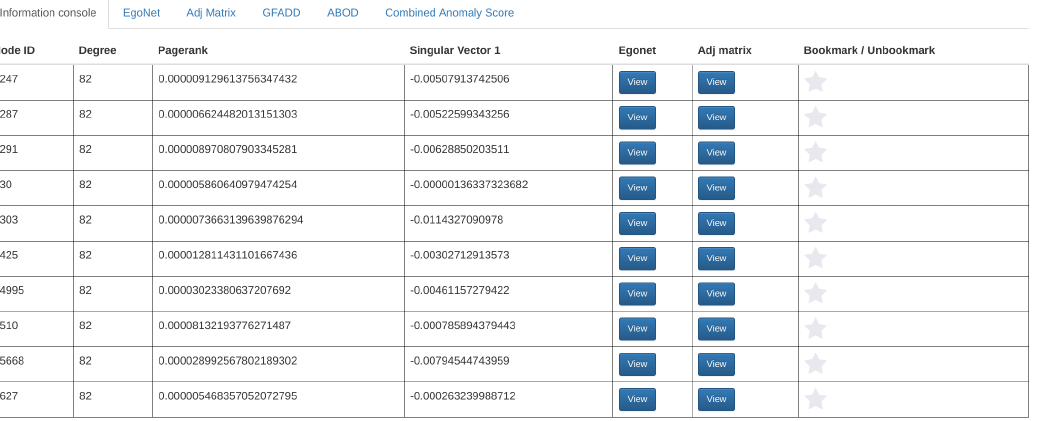
Figure 6. Layout of the information